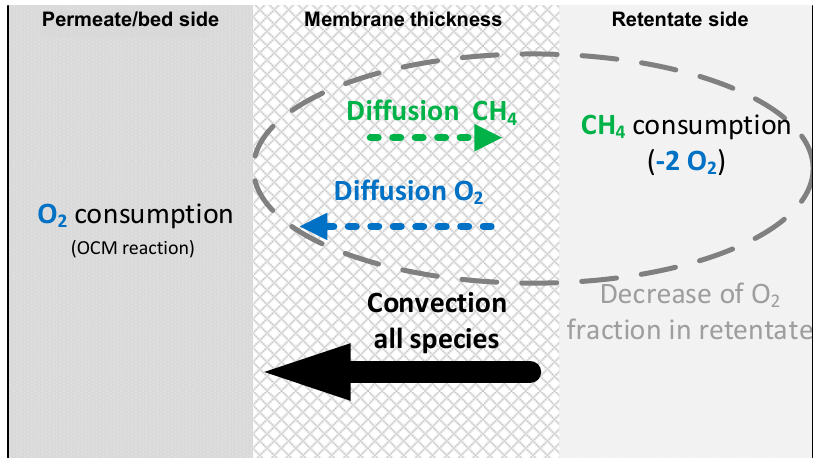
Figure 9. Schematic summary of the effect of diffusion and convection on membrane permeation.